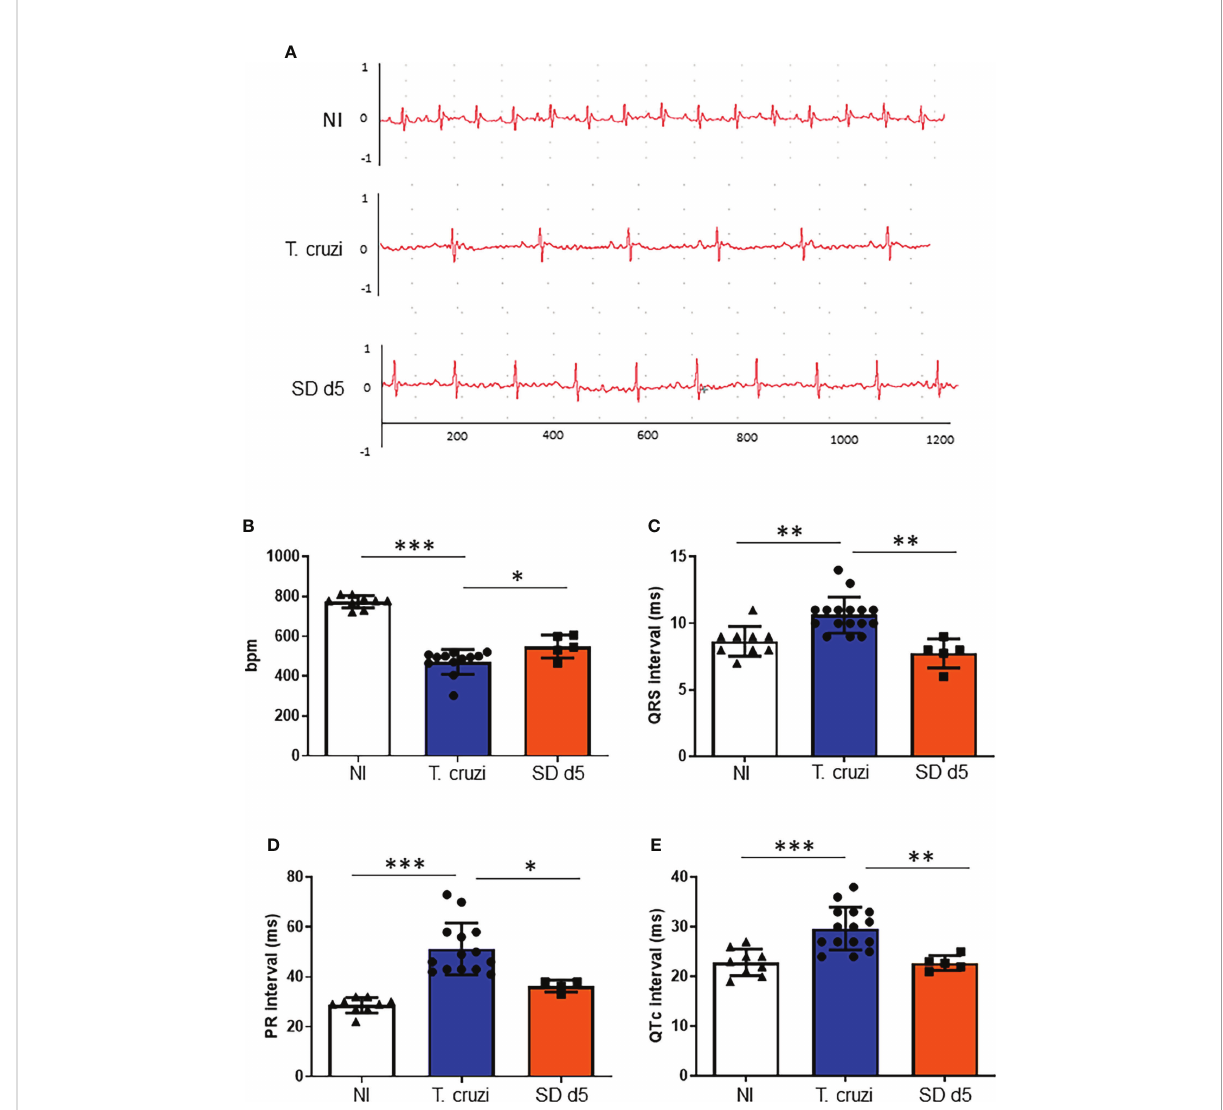
FIGURE 3 1D11 IP administration restored electrocardiographic parameters. 1D11 was administered at 5 dpi by intraperitoneal injection in male Swiss mice infected with 10 4 bloodstream trypomastigotes of the Y strain. Representative electrocardiographic tracings of each group at 15 dpi are shown (A) . 1D11 treatment resulted in best heart rate, in beats per minute (bpm) (B) ; PR interval in milliseconds (C) ; QRS interval (D) and QTc interval in milliseconds (E) . Signi fi cant differences between non infected and infected mice treated or not with 1D11 are indicated by *p< 0.05 **p< 0.01, ***p<